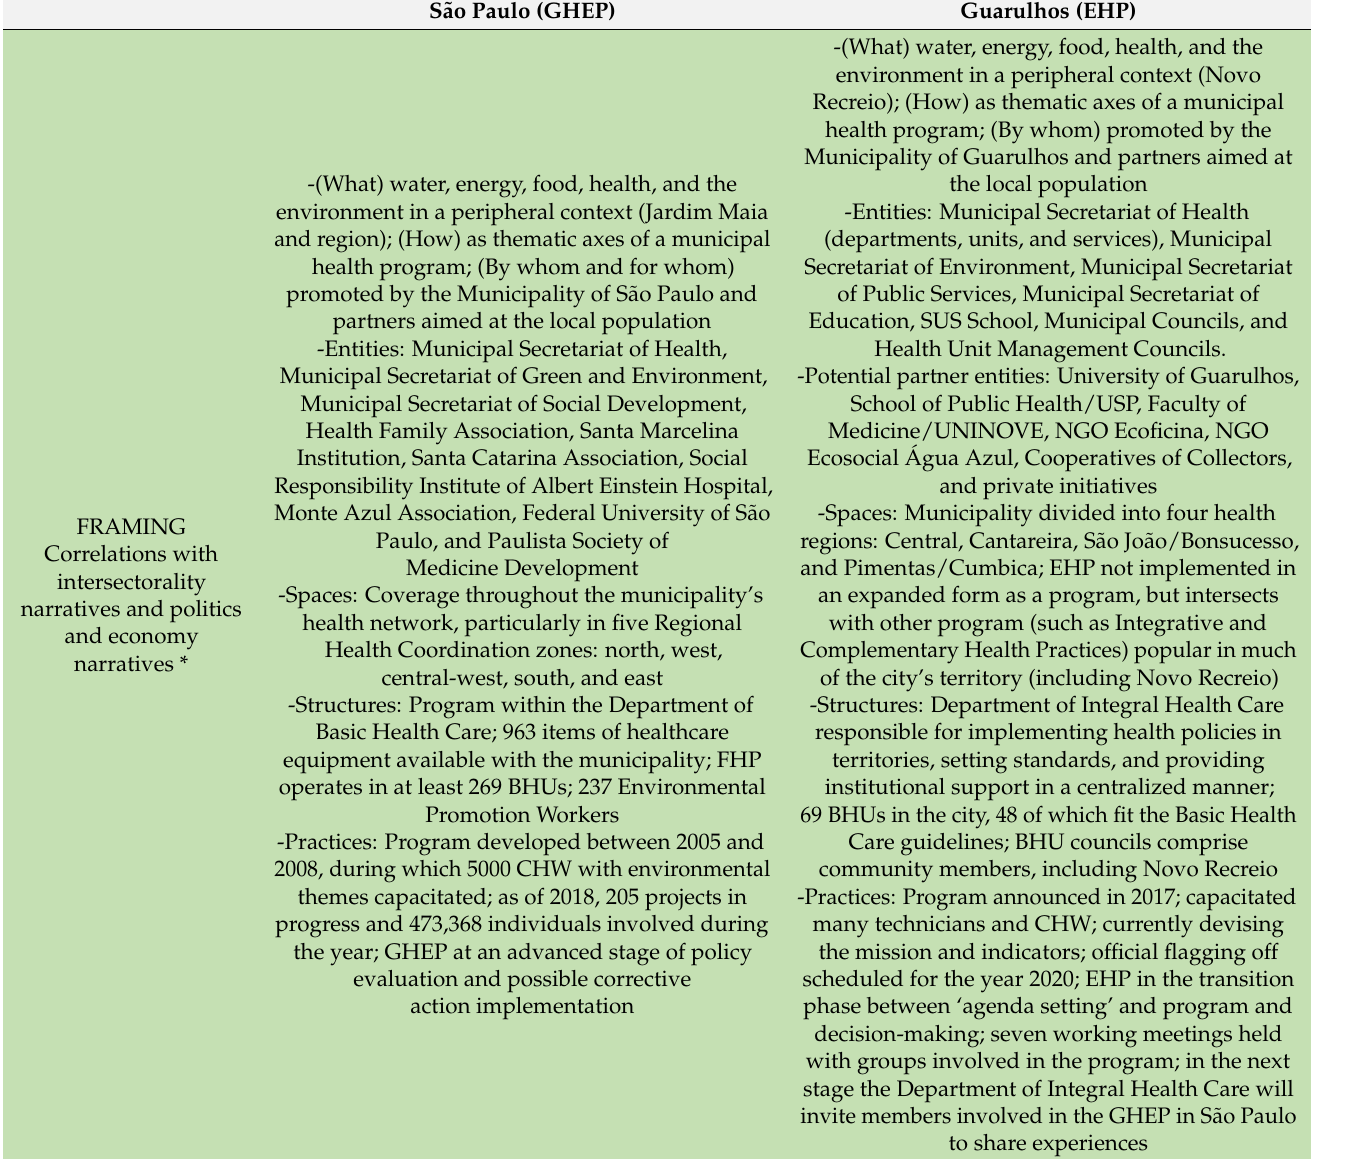
Table 1. Nexus of humility between WEF as a pathway to Sustainability from the case